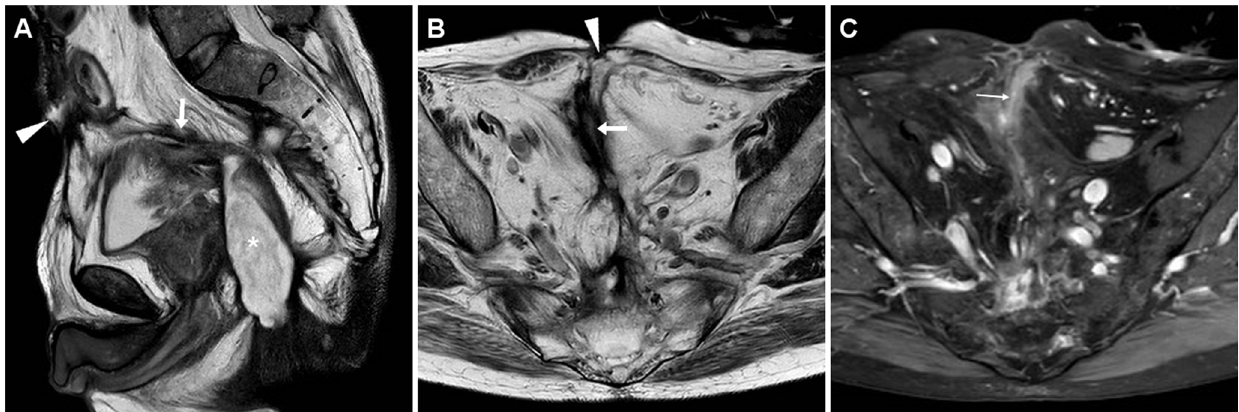
Fig. 7 MRI diagnosis of post-surgical ECF in a 65-year-old male with long-standing fistulising CD, previous abdomino-perineal resection for perianal fistulas complicated by anal squamocellular carcinoma (ASC). On T2-weighted images, the fluid-filled ECF (arrows) was seen coursing ventrally to reach the ventral EFO (arrowheads) at the site of past surgical